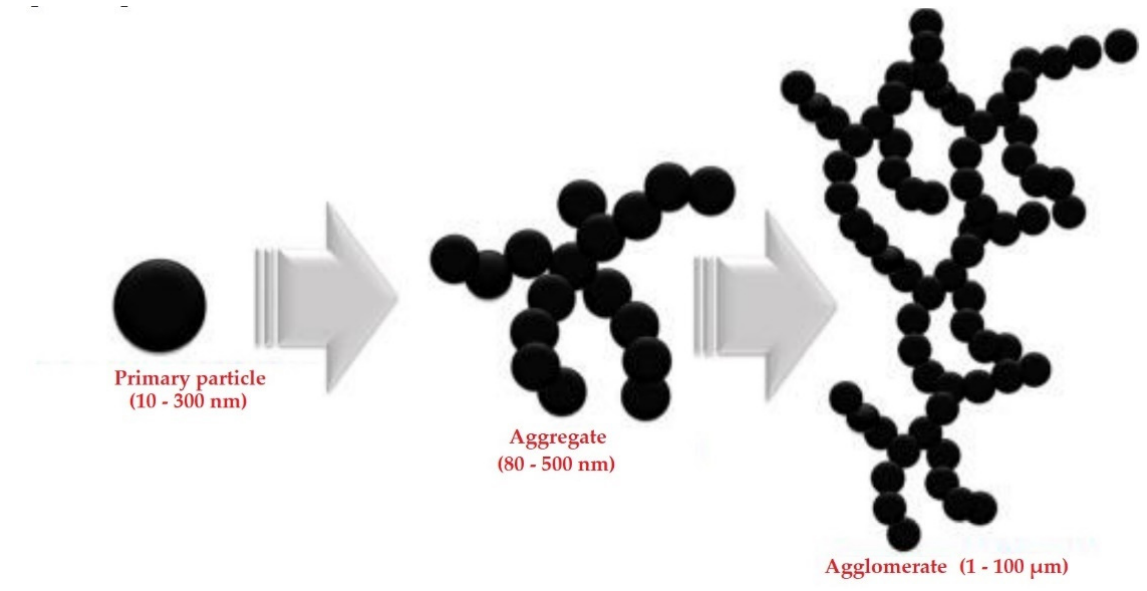
Figure 1. Carbon particles formed to aggregates in bulk phase. Reproduced from [36] with permission from Elsevier 2019.